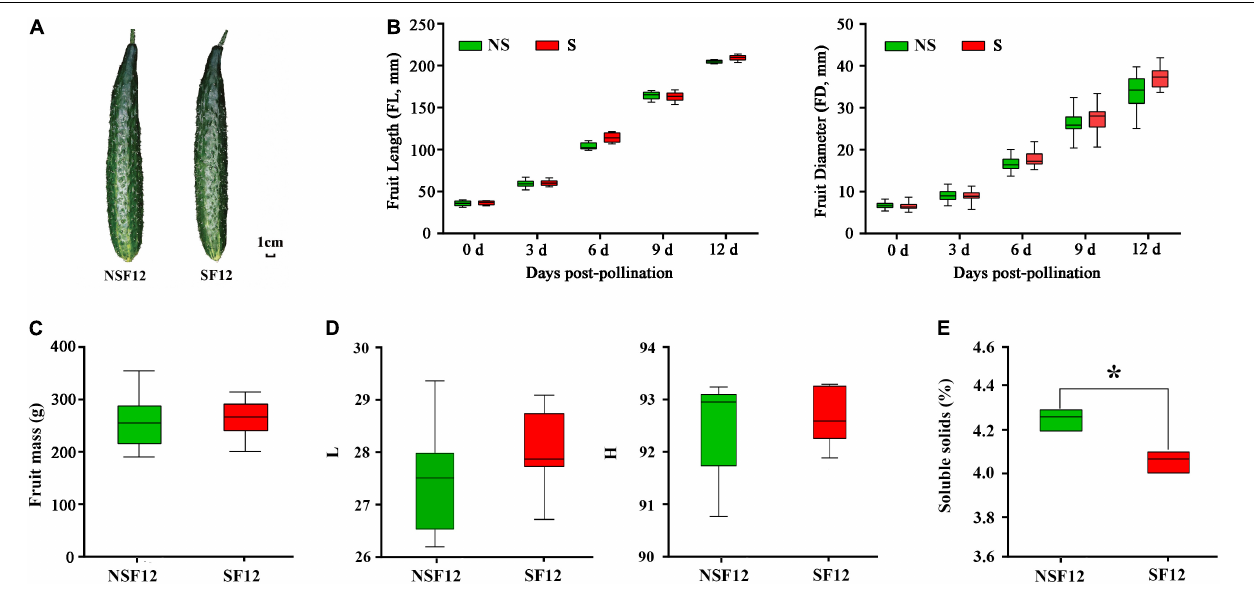
FIGURE 2 | The changes in fruit quality in non-fumigated and S-fumigated treatments. (A) The appearance at F12. (B) The changes in length and diameter during fruit development. (C) The fruit mass at F12. (D) The peel luminosity and hue angle at F12. (E) The content of soluble solids in F12. * indicates significant difference at P < 0.05, according to Duncan’s